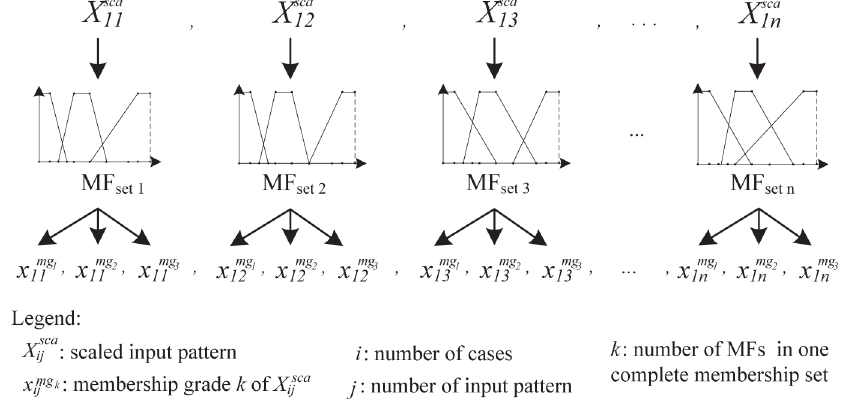
Fig. 4. Fuzzification